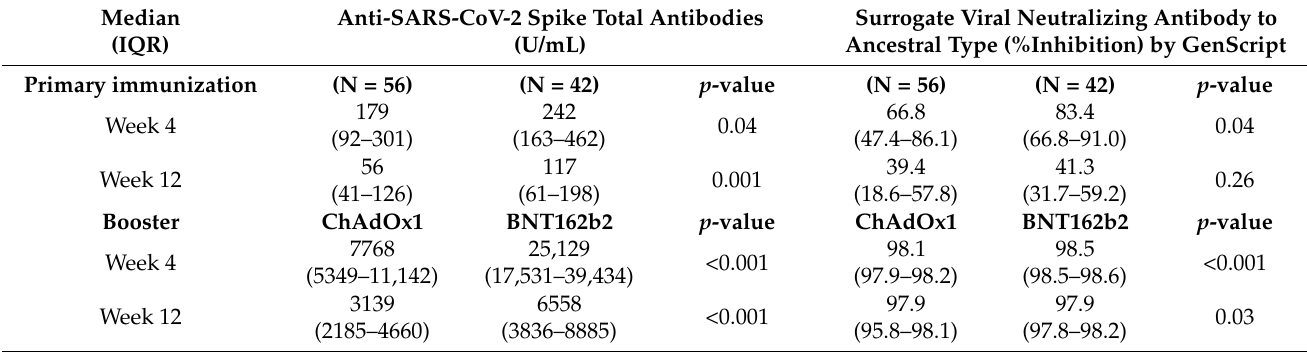
Table 2. Comparison of anti-SARS-CoV-2 spike total antibodies (U/mL) by Elecsys and surrogate viral neutralizing antibody to ancestral strain by GenScript in participants who received primary immunization with CoronaVac and booster with ChAdOx1 or BNT